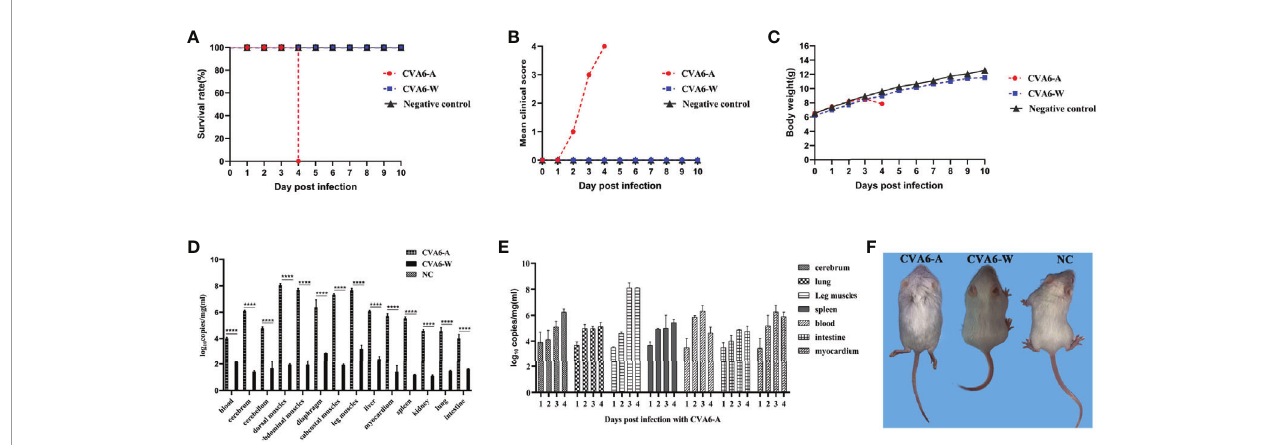
FIGURE 2 | The analysis of CVA6 infection features in 10-day-old suckling mice. When calculating the CVA6 load titer, qPCR was performed to measure the identical volume of CVA6-W (Gdula) and CVA6-A (adapted strain). Similar viral loads were obtained for both CVA6-W and CVA6-A that were intraperitoneally injected to infect 10-day-old suckling mice (5 per group). The survival rates (A) , clinical scores (B) , and body weight changes (C) were measured at the post-infected state. To detect the viral load via qPCR (D) , blood, brain, skeletal muscles, heart, liver, lung, and other tissues were collected from the mice. The cerebrum, lung, leg muscle, spleen, blood, intestine, and myocardium tissues of the mice, on various days (n = 5), were injected with CVA6-A and were measured using an identical method by CVA6 qRT-PCR (E) . Similar viral loads were obtained for CVA6-A, which caused the 10-day-old suckling mice to develop hind limb paralysis, unlike CVA6-W (F) . NC served as the negative control group of mice injected with PBS. ****p <